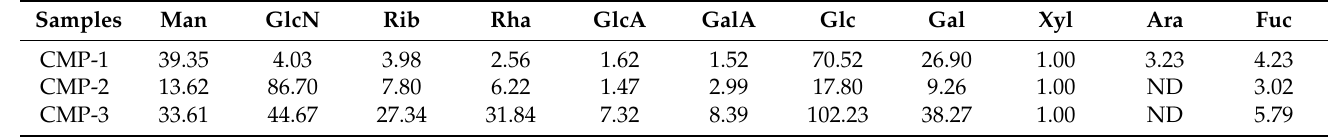
Figure 2. High performance gel permeation chromatography of CMP-1, CMP-2 and CMP-3. Table 1. The molar ratios of monosaccharide composition of CMP-1, CMP-2 and